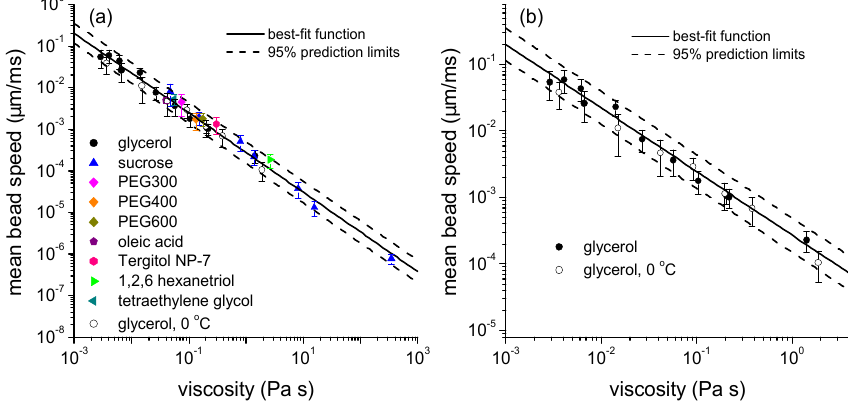
Fig. 6. (a) Average bead speed ( ± 1 σ ) vs. viscosity for the standard compounds listed in Table 1. (b) Average bead speed ( ± 1 σ ) vs. viscosity for aqueous solutions of glycerol at 0 ◦ C and room temperature in order to display the effect of temperature on the bead speed vs. viscosity results. A calibration line was fit to all of the standard mean bead speed data from the standard compounds. Unless indicated in the figure legend all data correspond to room temperature (20–21.5 ◦ C). Polyethylene glycols with average molecular weights of 300, 400, and 600gmol − 1 are abbreviated as PEG300, PEG400, and PEG600, respectively.